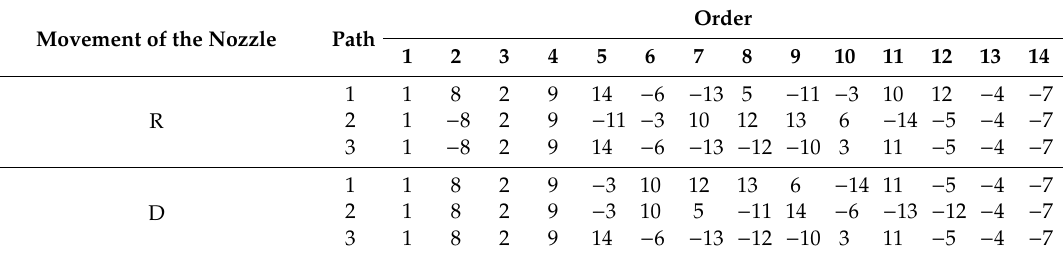
Table 9. Best solutions for the 14-wall flat (Example 3) with T =